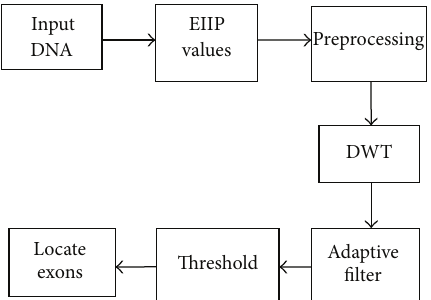
Figure 5: Block diagram for location of protein coding region using